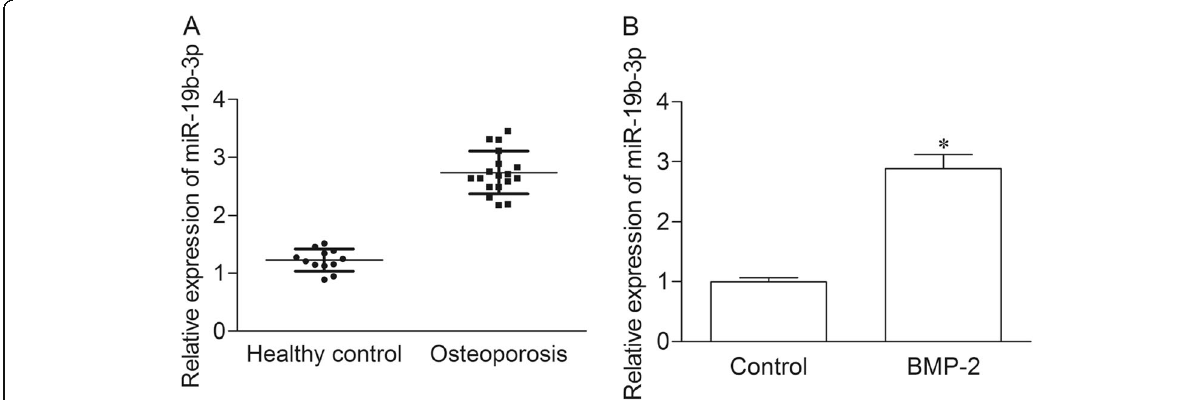
Fig. 1 MiR-19b-3p is up-regulated in postmenopausal osteoporosis patients and BMP-2-induced BMSCs. ( a ) The expression of miR-19b-3p in the serum of postmenopausal osteoporosis patients and heathy controls were measured by qRT-PCR. Each specimen was repeated three times. ( b ) Control group, normal BMSC cell; BMP-2 group, BMSC cell treated with 100 ng/mL BMP-2. * P < 0.05 versus healthy control